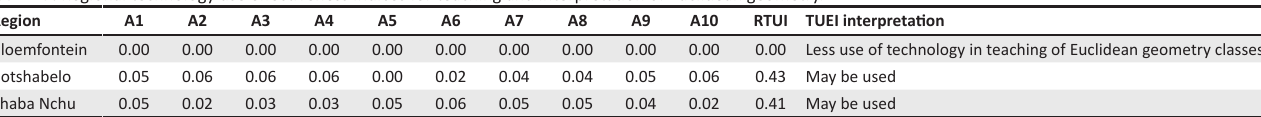
TABLE 7: Regional technology use effectiveness indices for teaching and interpretation of Euclidean geometry. Region